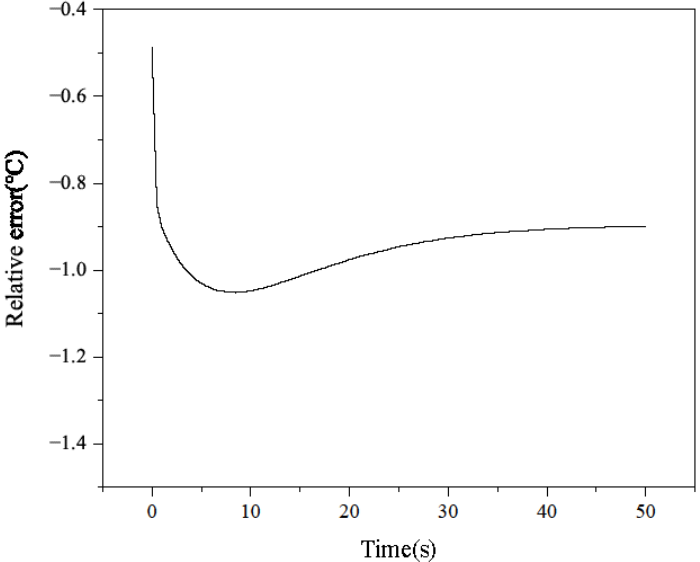
Figure 9. The relative error between the backward equation method and the original method of a 2% step increase in inlet helium temperature.